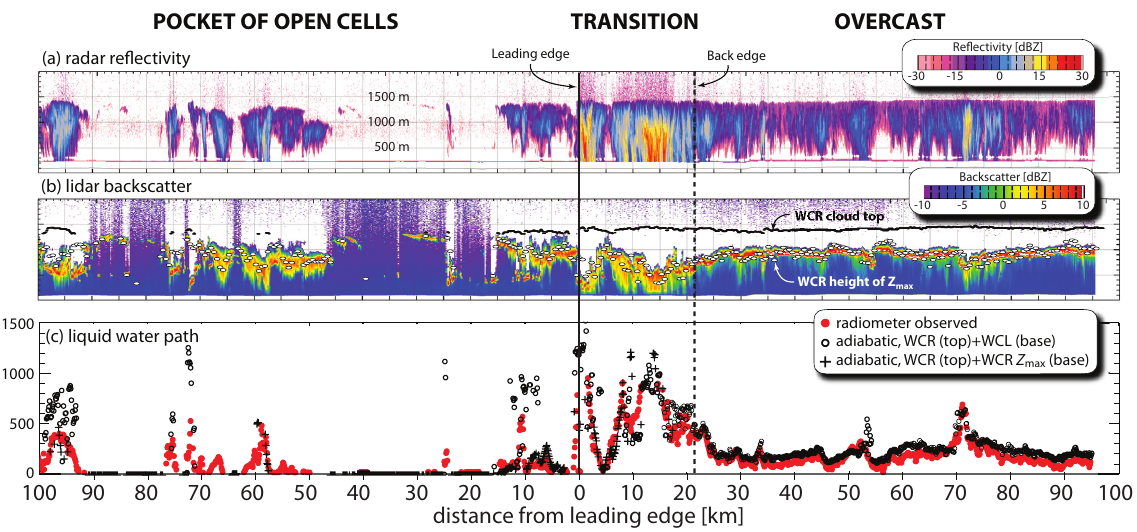
Fig. 12. Time series, from leg SC2 of RF06, of (a) WCRradar reflectivity; (b) WCL lidar backscatter, with WCR cloud top (1Hz) and the height of the maximum WCR reflectivity (ovals, smoothed with 7s triangular filter and plotted every fifth point for clarity) overlaid; (c) liquid water path from the microwave radiometer (red circles) and estimated using two adiabatic models. Both models use the WCR observed cloud top height, but one uses the lidar-derived cloud base height where available (open circles), and the other uses the height of the maximum WCR radar reflectivity as a proxy for the cloud base height (crosses) where strong drizzle precludes accurate WCL cloud base height estimates.